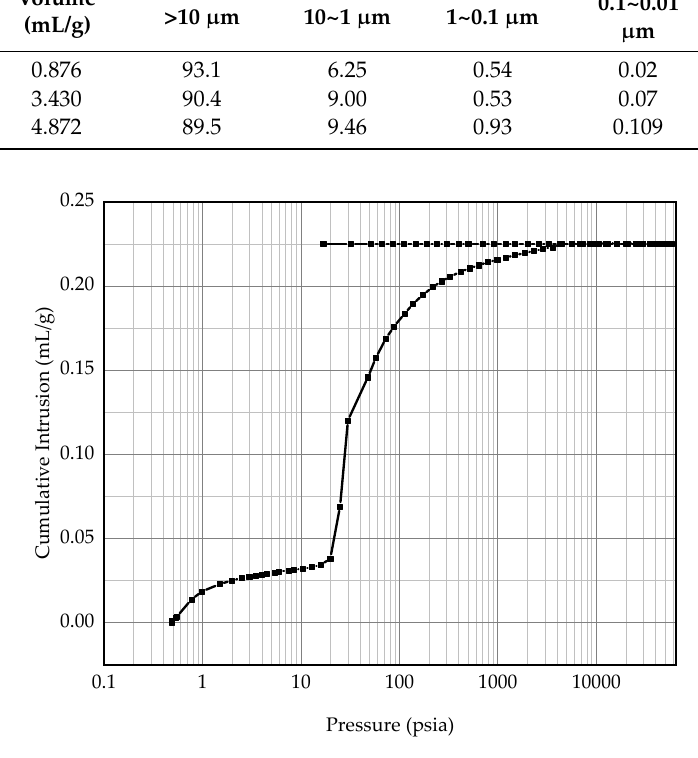
Figure 13. Mercury injection–mercury removal curve of soil sample 1.